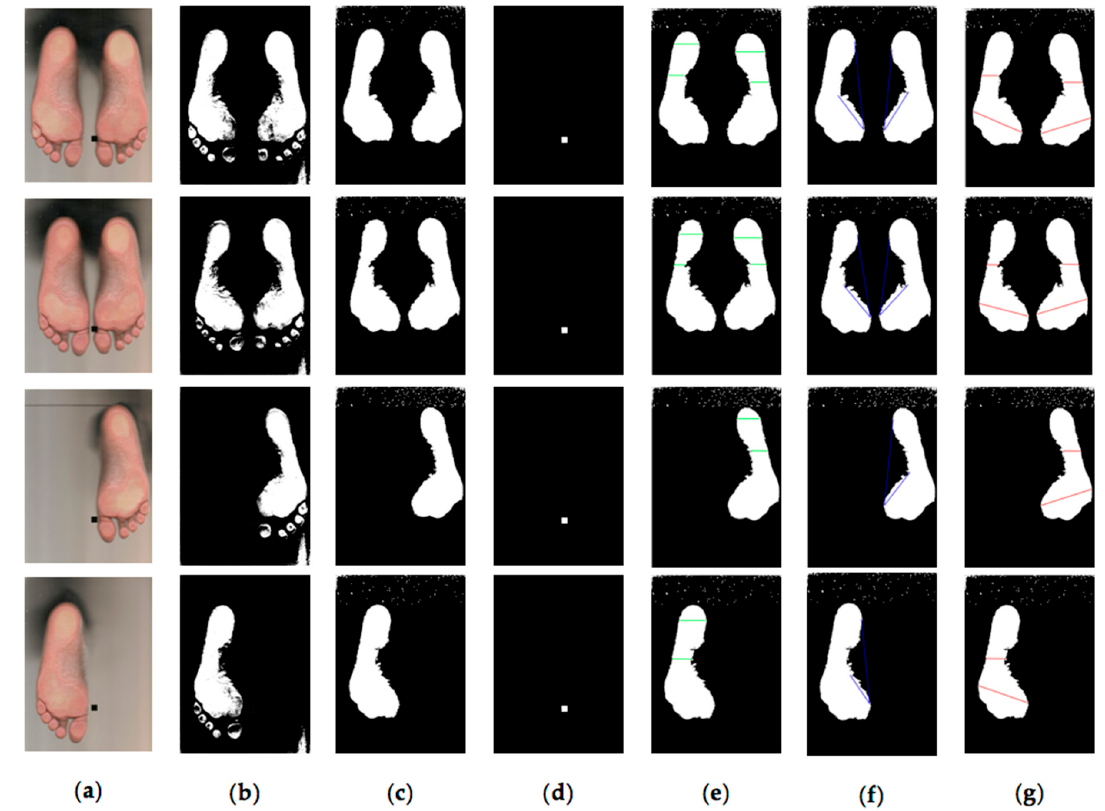
Figure 9. Steps of the algorithm for the analysis of the footprint: ( a ) RGB image obtained from podoscope; ( b ) Thresholding at 183 of red channel; ( c ) Segmentation of the footprint and removal of toes; ( d ) Location of the reference (square centimeter) in the image; ( e ) Staheli arch index; ( f ) Clarke’s angle; ( g ) Chippaux-Smirak index.